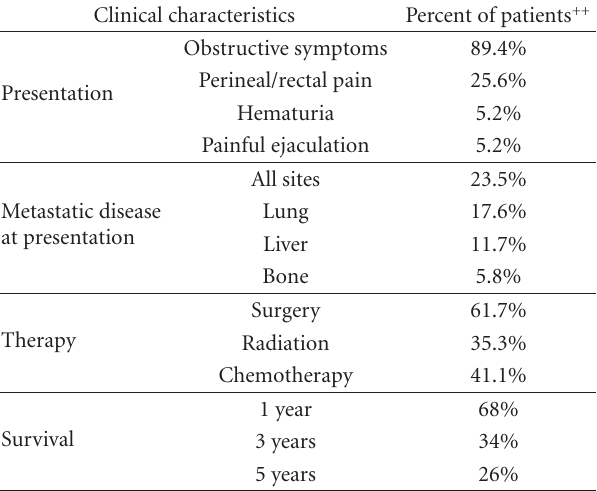
Table 2: Clinical characteristics of patients with prostate leiomyosarcoma (retrospective review of 55 patients including this